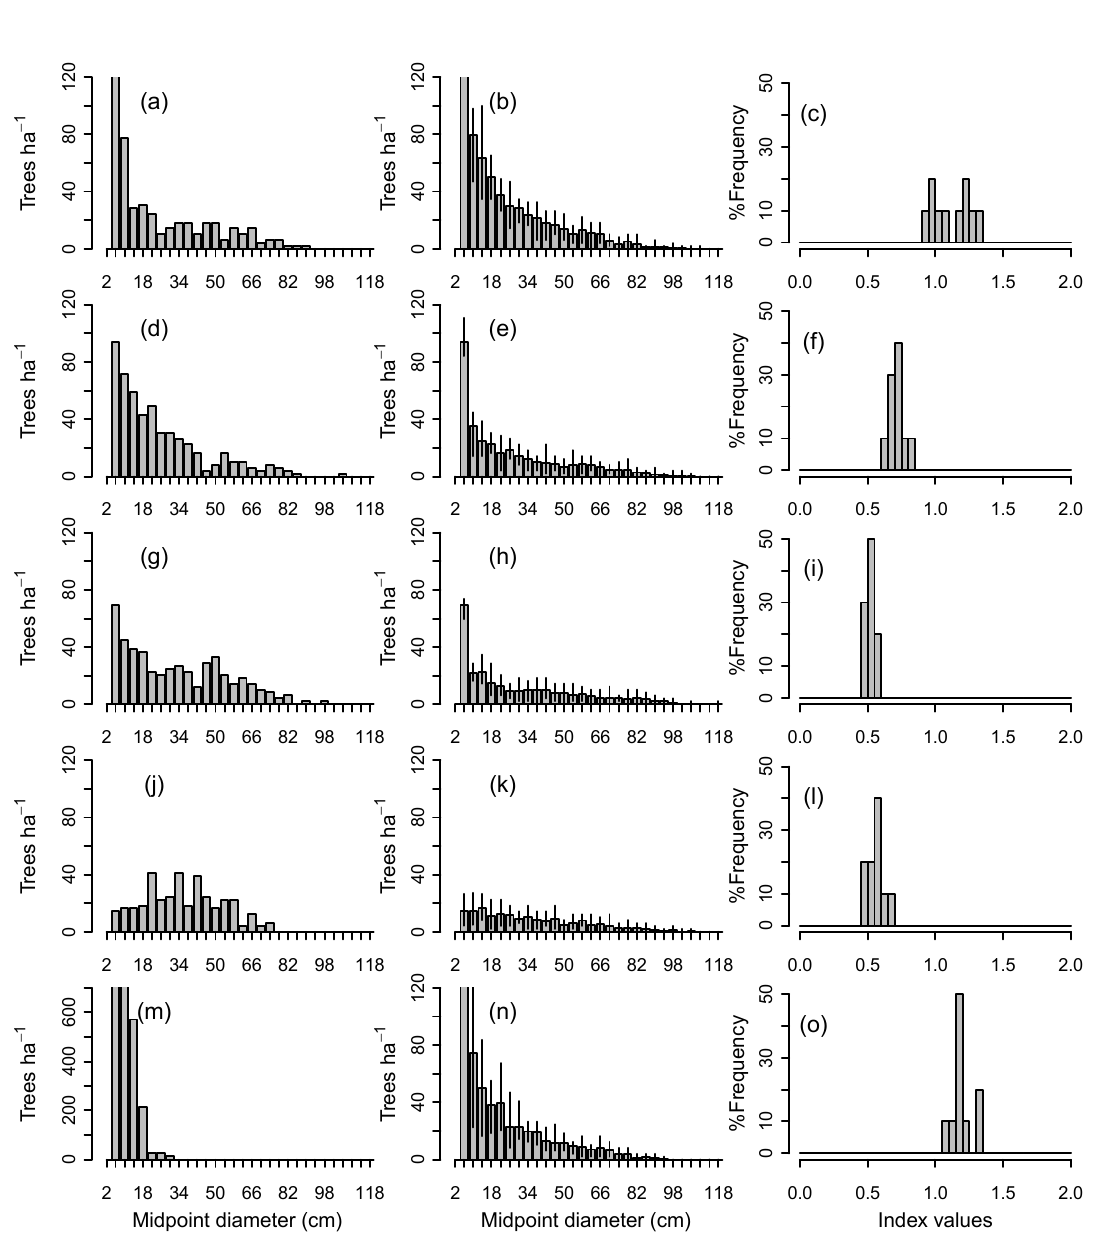
Figure 2. Predicted size distributions and demographic sustainability indices for five 0.5 ha plots with a variety of initial diameter distributions from the 1981–1984 upper Michigan field survey. Each plot was simulated 10 times for 500 years, with the number of 2–6 cm DBH (diameter at breast height) saplings maintained constant at initial levels (Group 1a simulations). Left column: initial diameter distributions ( a , d , g , j , m ). Middle column: projected diameter distributions for the five plots in simulation year 500 ( b , e , h , k , n . bars = means; whiskers = range of variation for the 10 replicates). Right column: distribution of sustainability index values for the five plots with all species pooled ( c , f , I , l , o ).